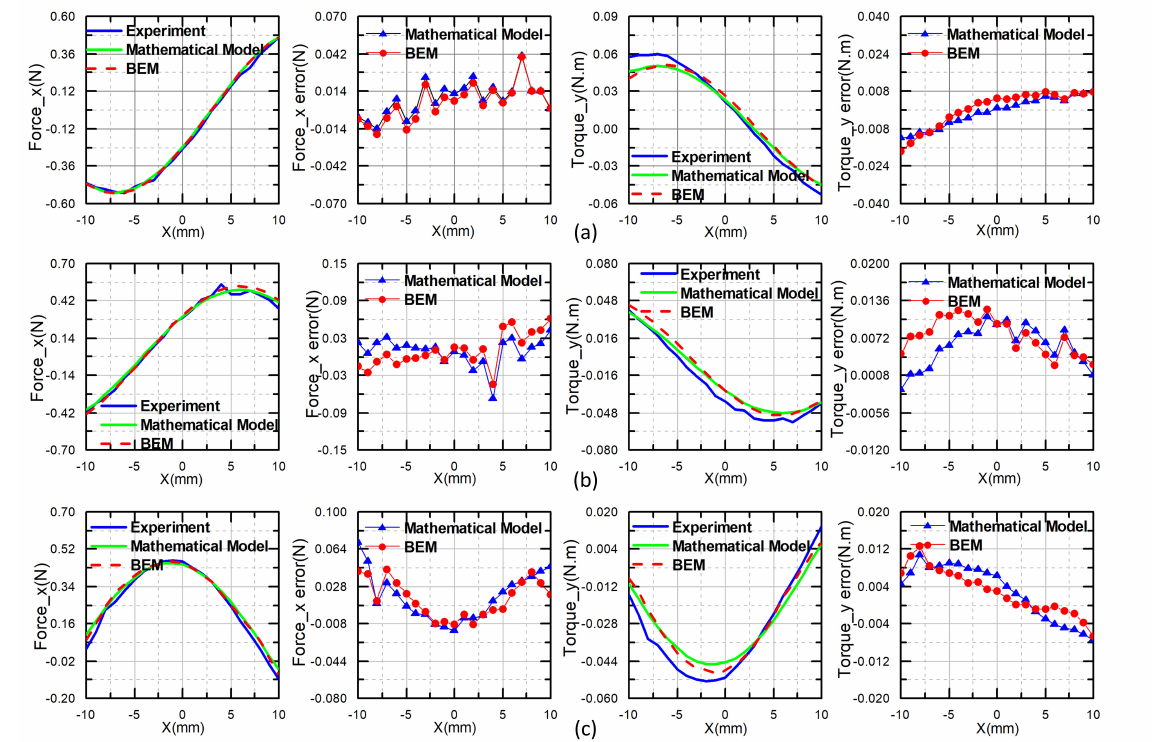
Figure 7. The measurement, boundary element model (BEM), and calculation results, c x p ∈ [ − 10 mm, 10 mm ] and c z p = 13 mm. ( a ) γ = 5 ◦ , ( b ) γ = 10 ◦ , ( c ) γ = 15 ◦